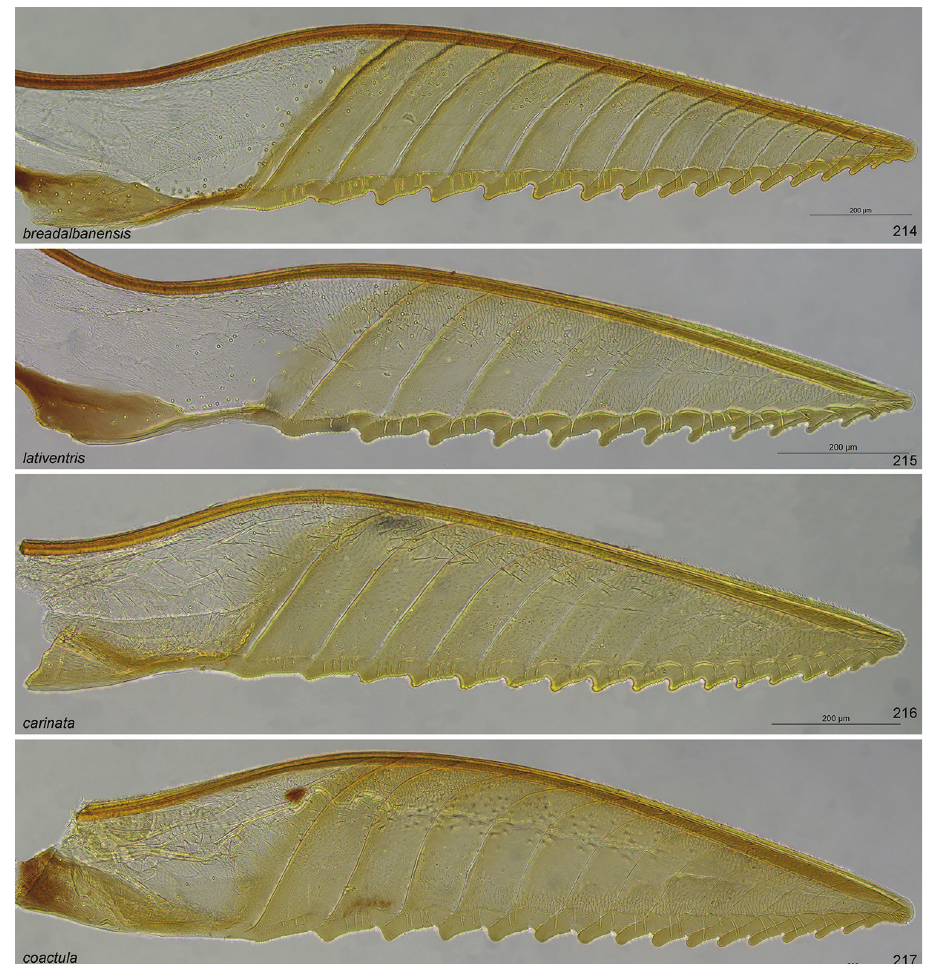
Figures 214–217. Lancets of Pristiphora . 214 breadalbanensis DEI-GISHym17784 215 lativentris DEI-GISHym80240 216 carinata DEI-GISHym20847 217 coactula